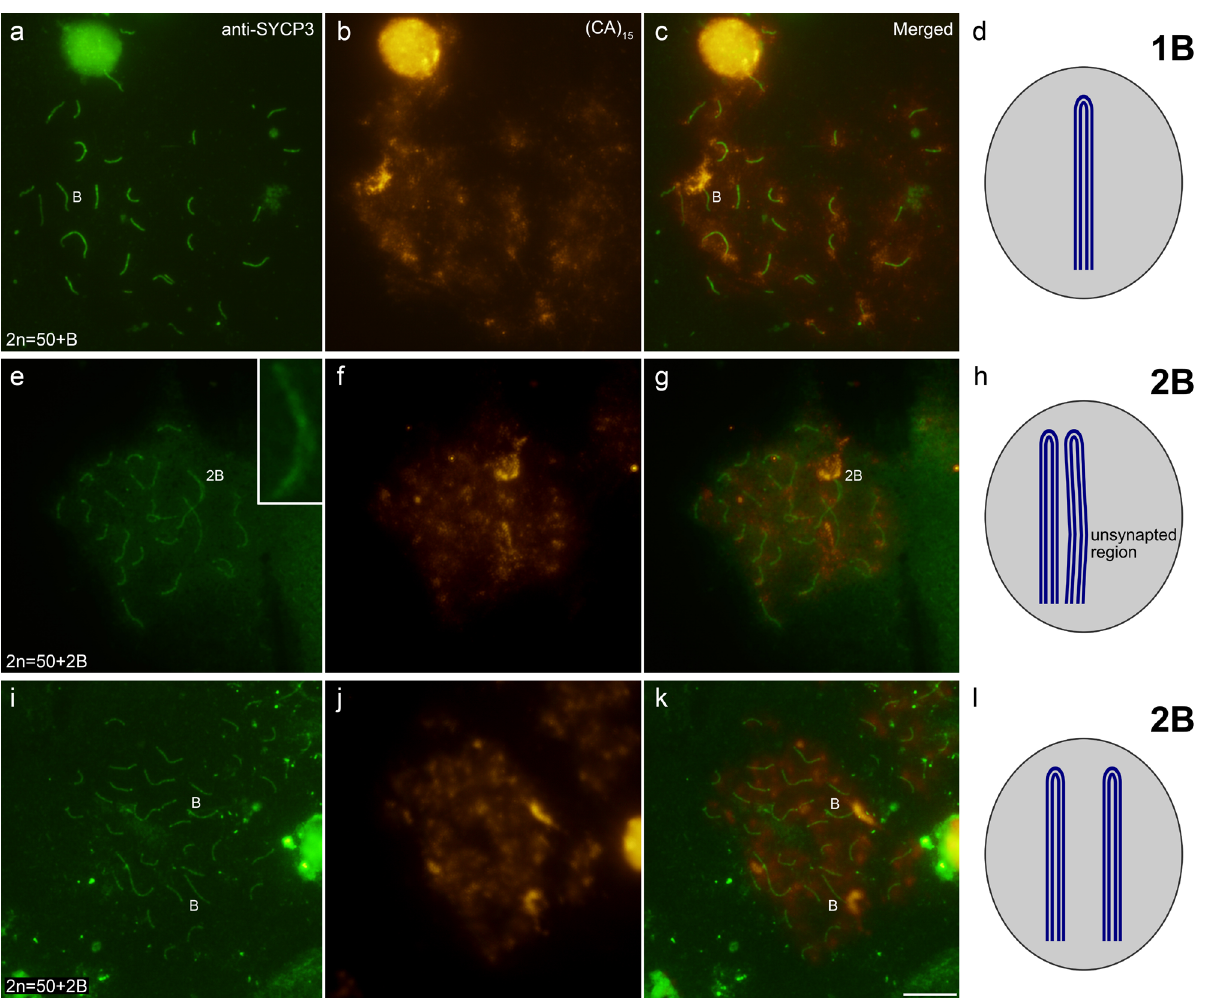
Figure 3 – Detection of P. paranae synaptonemal complexes through immunodetection using an anti-medaka SYCP3 antibody (A, E, I) and FISH with a (CA) probe (B, F, J). Diploid number of individuals are indicated in the lower left corner (A, E, I). In the inset of e, note a region not fully associated in 15 the lower half of the SC association formed by two self-paired B chromosomes. C, G, and K show the combination of images obtained by immunodetection and FISH. D, H, and L present an illustration of the meiotic behavior of the B chromosome. In all individuals, B chromosomes show a self-pairing behavior and in 2B individuals, they can stay close or separated. In the first case, they can appear not perfectly paired to each other. Bar = 10